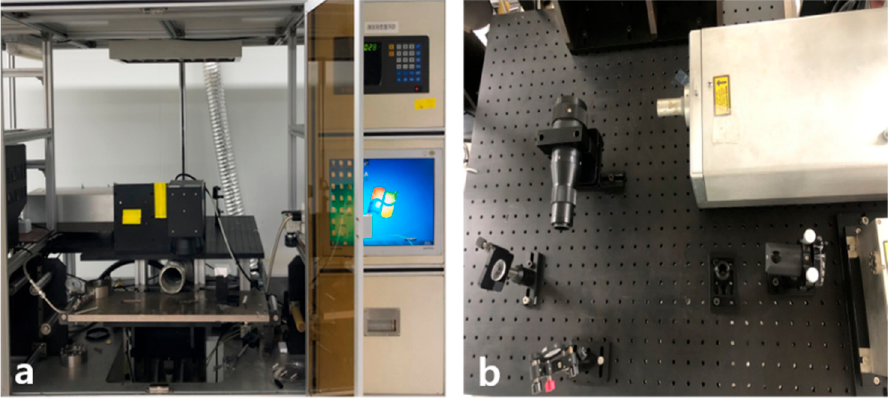
Figure 1. ( a ) Laser set-up; ( b ) optical system.